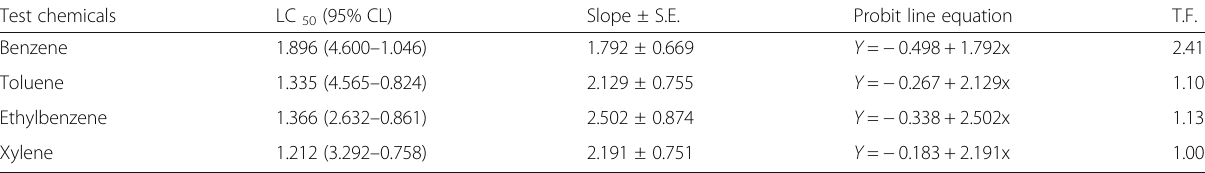
Table 2 Comparative acute toxicity of benzene, toluene, ethylbenzene, and xylene acting singly against E. eugeniae Test